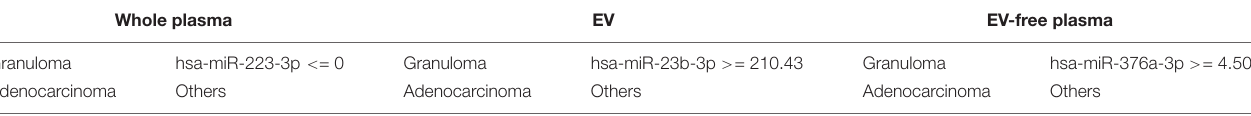
TABLE 2 | The RIPPER rules in whole plasma, EV and EV-free plasma. Whole plasma EV EV-free plasma Granuloma Others Adenocarcinoma Others